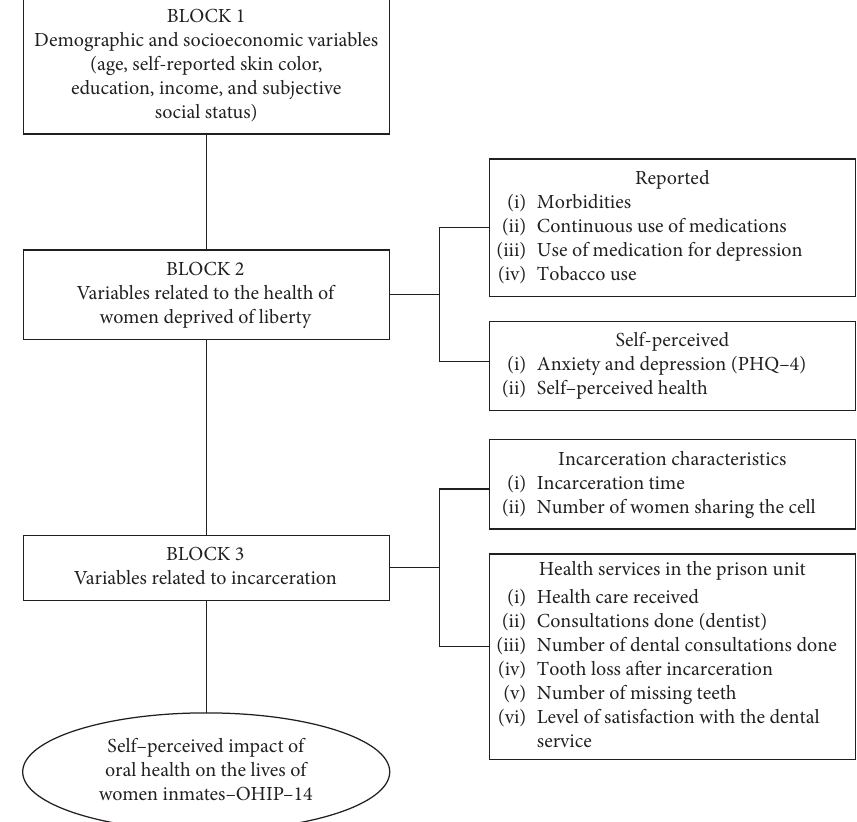
Figure 1: Theoretical model for investigating the effects of the independent variables on the self-perceived impact of oral health on the lives of women, in hierarchical